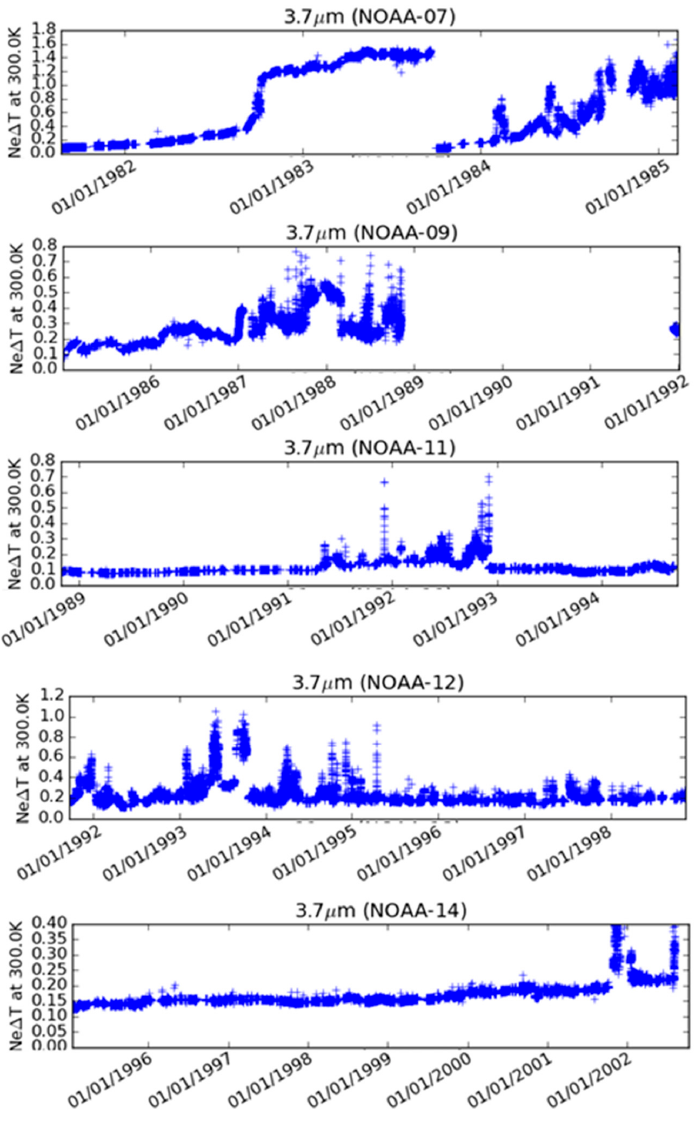
Figure 4. Channel 3b noise, expressed as noise equivalent temperature variation (Ne Δ T) at the 300 K level, during the lifetime of satellites NOAA-7, NOAA-9, NOAA-11, NOAA-12 and NOAA-14.